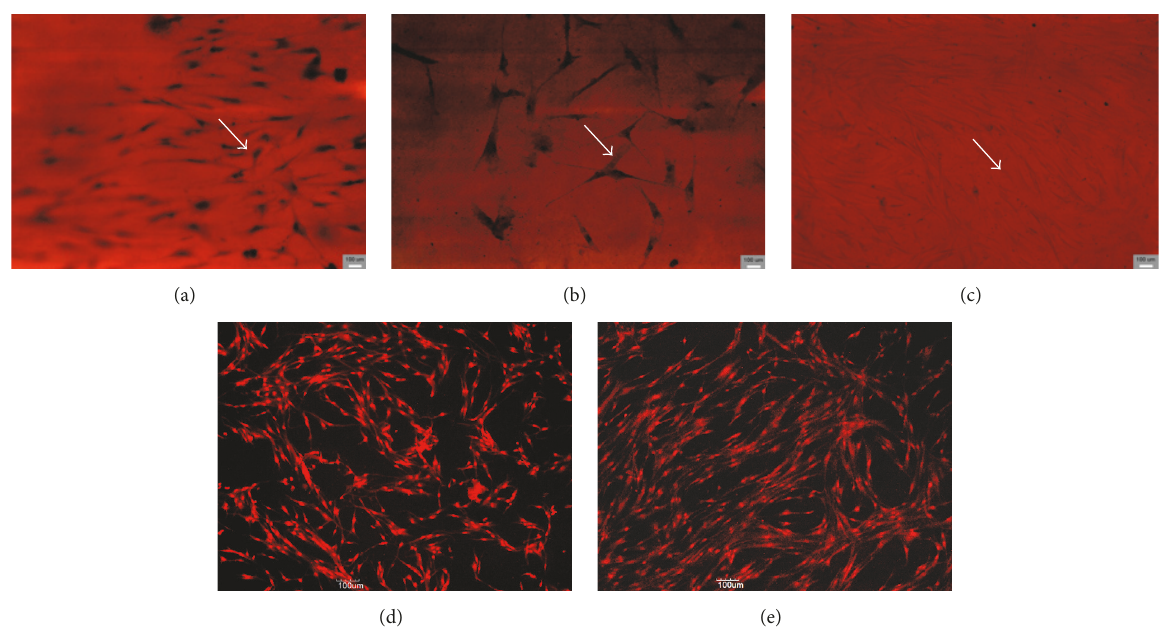
Figure 3: In vitro cell adhesion on biomaterials, haematoxylin-eosin staining incubation time of 8 days. (a) PVA, (b) PVA/BC, and (c) BC. Imagestakenat40x.Whitearrowsindicatethepresenceofcells.Celldensities:PVAandPVA/BCnotdetectable;BC56934 ± 4657.Fluorescent images of fibroblast on BC, (d) 4th day and (e) 8th day. Dye: ethidium bromide, cell nucleus is brighter than cytoplasm. Images token at 40x. Fibroblasts increase their number on BC. At the 4th day cells are spread on the surface of BC surface. At the 8th day, cells display a confluent monolayer on the surface of the biomaterial. Scale bar is 100 𝜇 m.